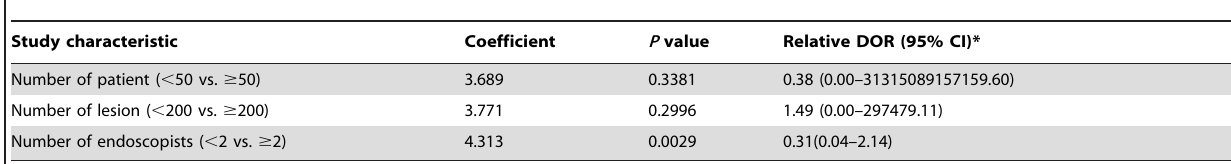
Table 3. Meta-regression for the potential source of